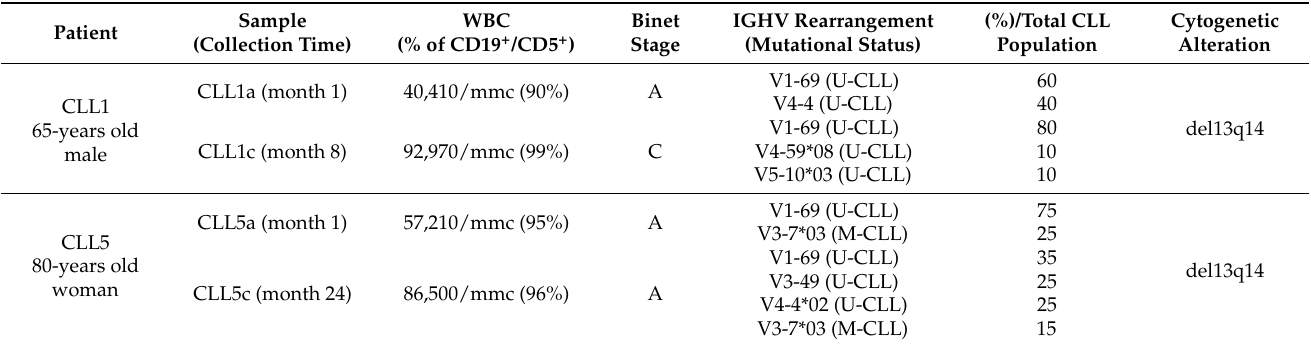
Table 1. Summary of clinical and biological features of CLL1 and CLL5 patients. Three blood samples were collected at various timepoints for each patient, but for this study we used the first and the last samples collected. CLL clones were identified by the analysis of the clonotypic BCR IG gene rearrangement through Sanger sequencing (GenBank accession numbers MT334403 to MT334414). As shown, the IGHV1-69 clone was the only one persisting in both patients during the follow-up period at various size levels in respect the total CLL population. Despite both patients carrying the same genomic aberration del(13q14), CLL1 showed disease progression through a shift from Binet stage A to C and required therapy, while the disease remained stable in patient CLL5 (Binet classification is in accordance with Cancer.net Editorial Board, October